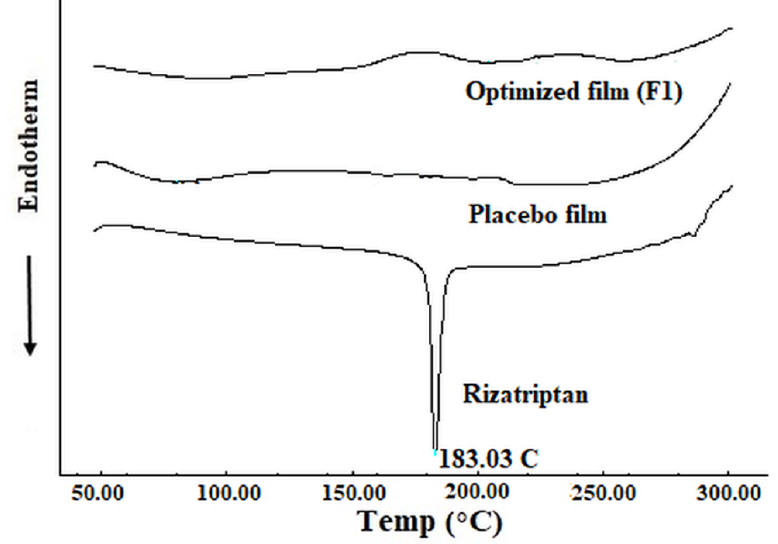
Figure 3. Differential scanning calorimetric curves of rizatriptan, drug loaded film (F1) and placebo film.